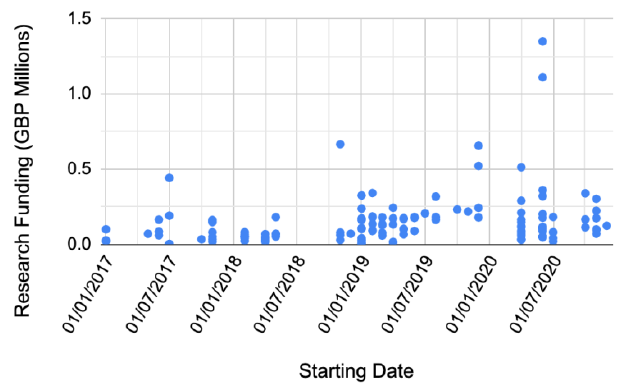
Figure 9: Innovate UK-funded blockchain-related research and development projects.